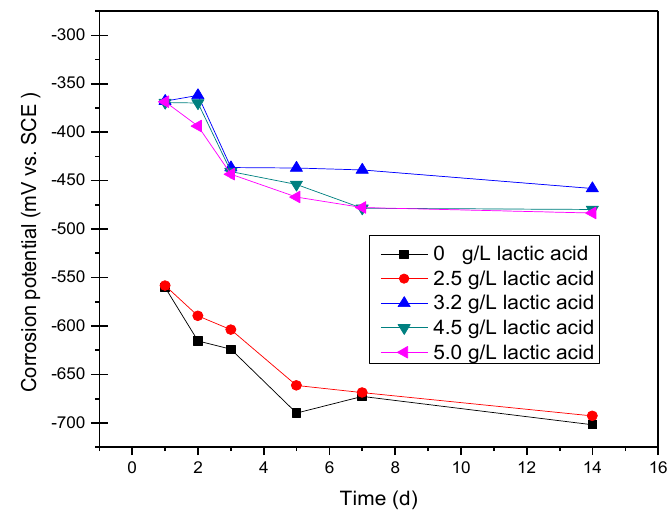
Figure 2. Open-circuit potential of titanium immersed in artificial saliva containing different amounts of lactic acid. SCE, saturated calomel electrode.